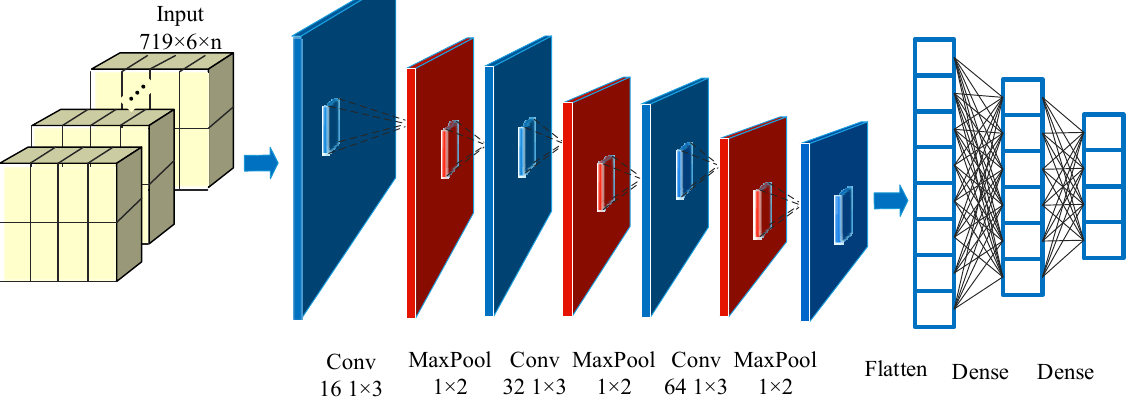
Figure 3. CNN model detailed structure diagram. Table 1. Values of confidence factors.